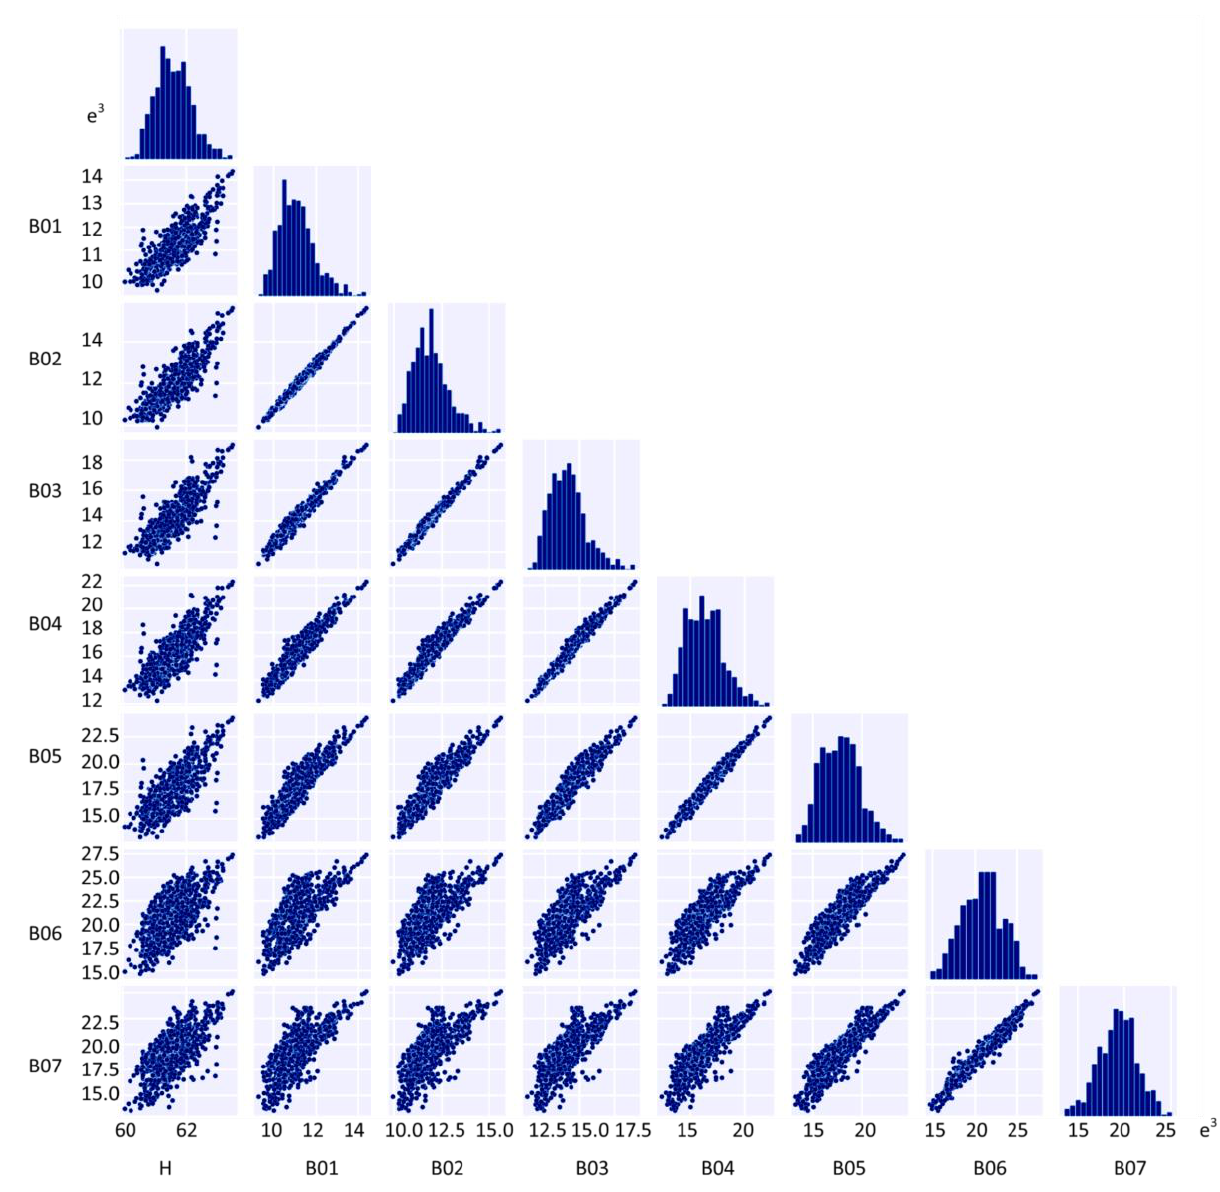
Figure 4. Pair scatter plot of the data collected by a 10 × 10 window sampler around 200 GCPs for Hyperion band (H) B020 against the 7 L8 bands (B01 – B06), where numbers are reduced to (e 3 = ×1000) form.